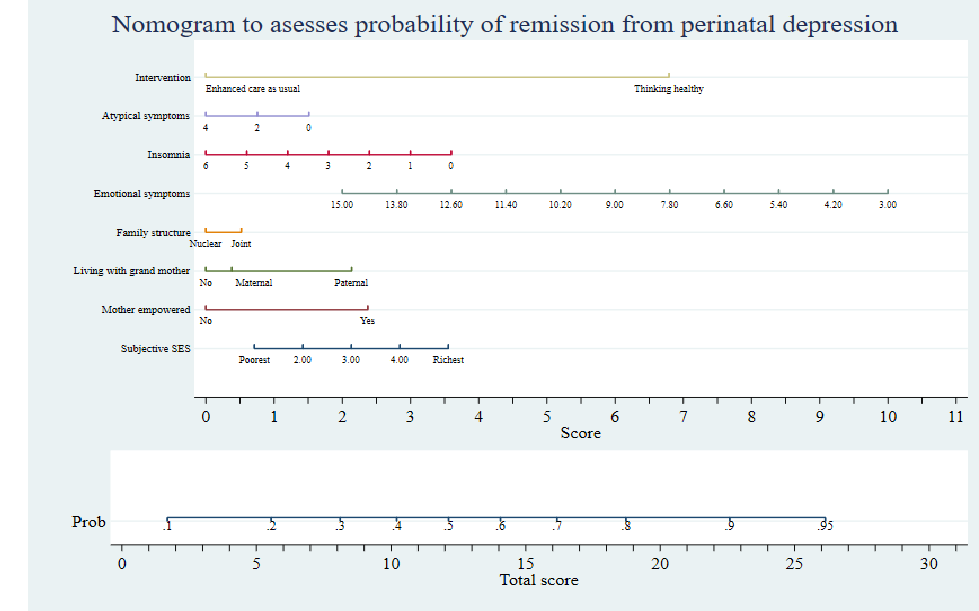
Figure 4. Nomogram presenting the prognostic model for use in the primary care setting.